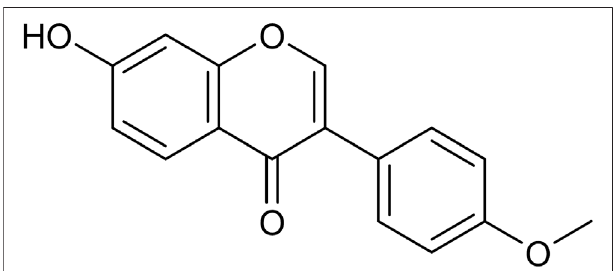
FIGURE 1 | The chemical structure of